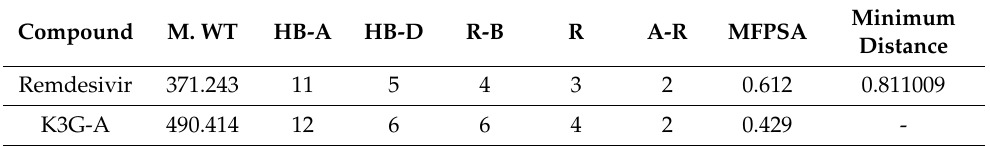
Table 2. Structural properties of K3G-A and remdesivir, F86.